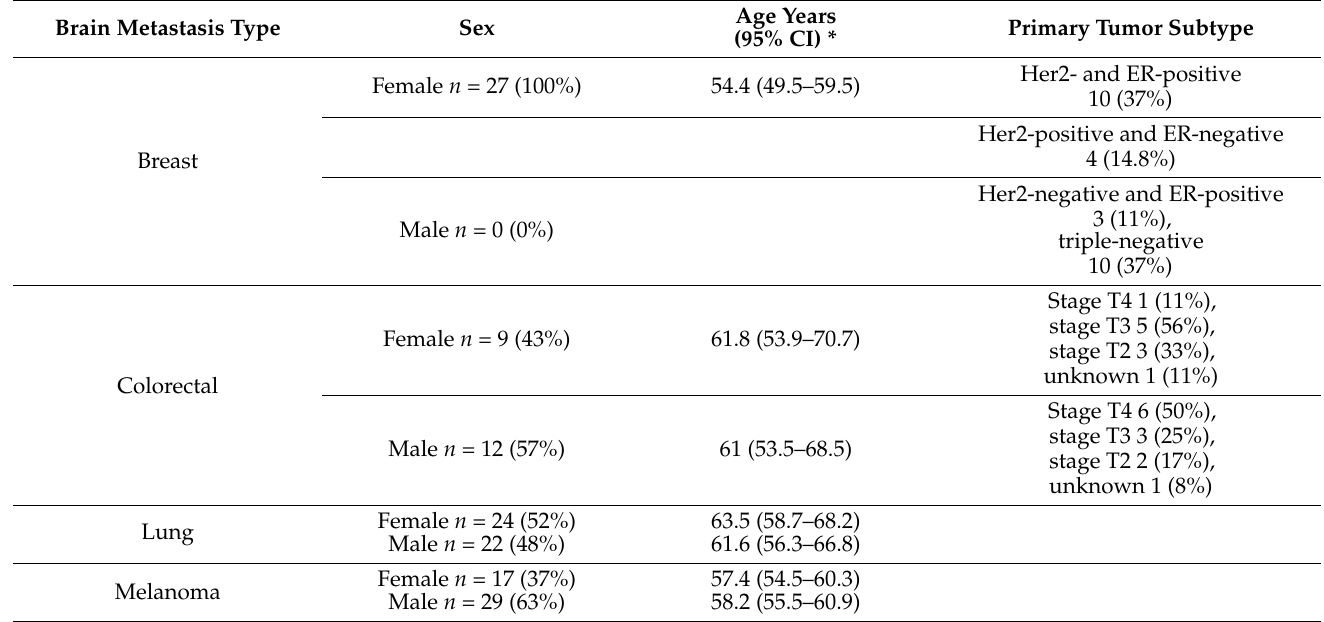
Table 1. Patient demographics of the brain metastasis